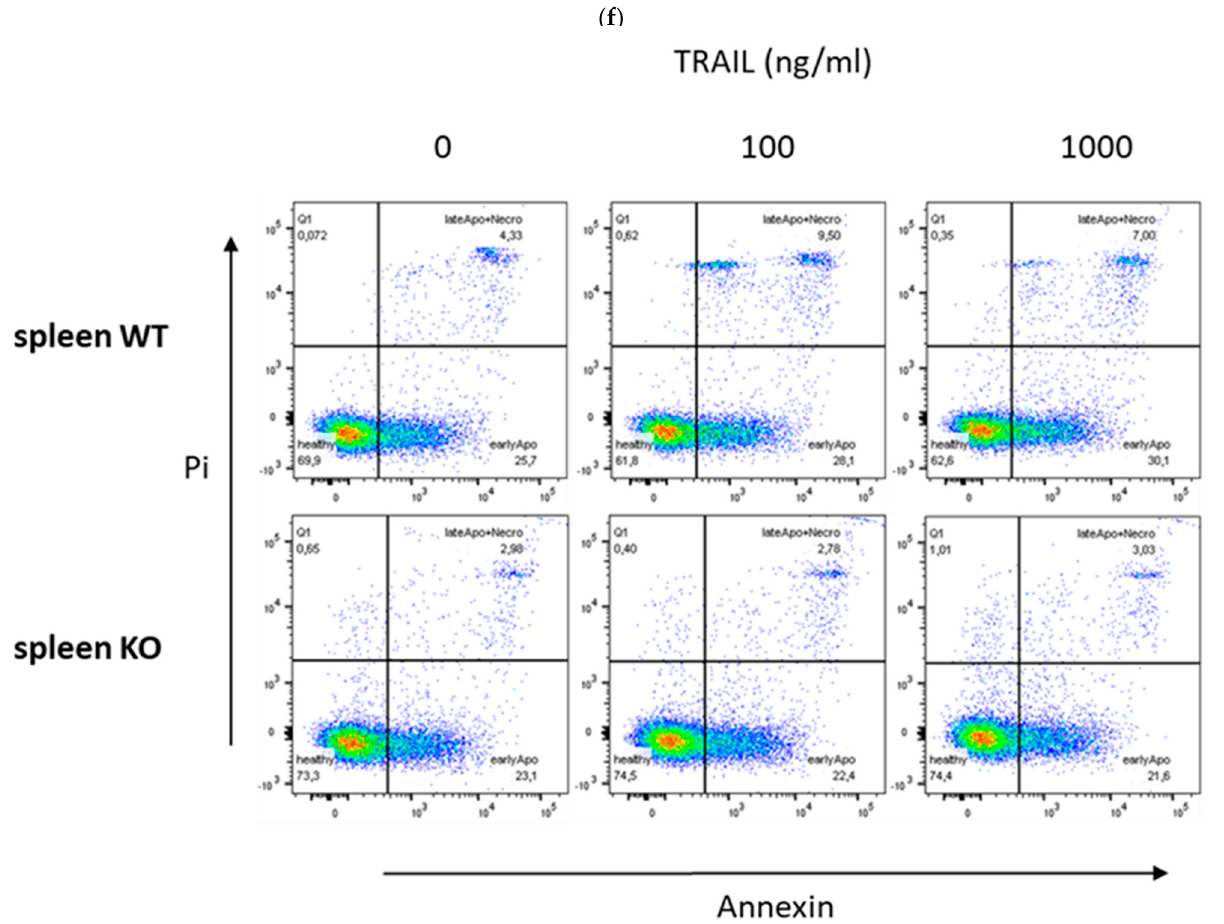
Figure 3. Recombinant TRAIL did not stimulate apoptosis in neutrophils derived from naïve mice in vitro. Neutrophils isolated from bone marrow ( a , b ) and spleen ( d , e ) of naïve WT and TRAIL–/– mice ( n = 5 each) were stimulated with different concentrations of TRAIL (0 ng/mL, 100 ng/mL, 1000 ng/mL) in vitro. Representative FACS plots show staining of neutrophils derived from the bone marrow ( c ) and the spleen ( f ). The level of early ( a , c ) and late ( b , d ) apoptosis in neutrophils with and without TRAIL treatment are shown. Graphs show means ± SEM (* p < 0.05, ** p < 0.01).